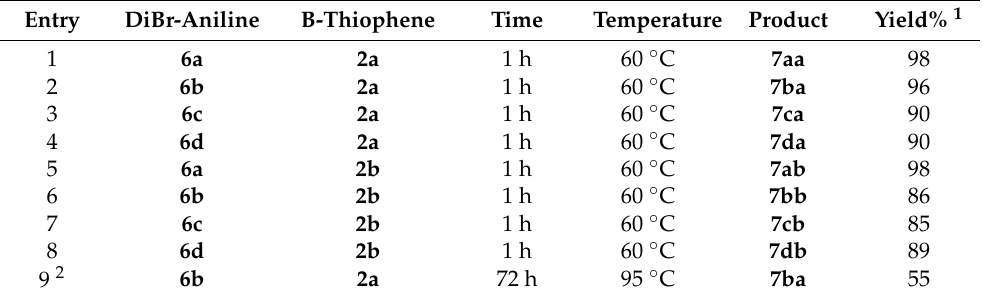
Table 3. Output of micellar Suzuki cross-coupling between di-bromoanilines and thienyl boronic acids. Entry DiBr-Aniline B-Thiophene Time Temperature Product Yield% 1 1 6a